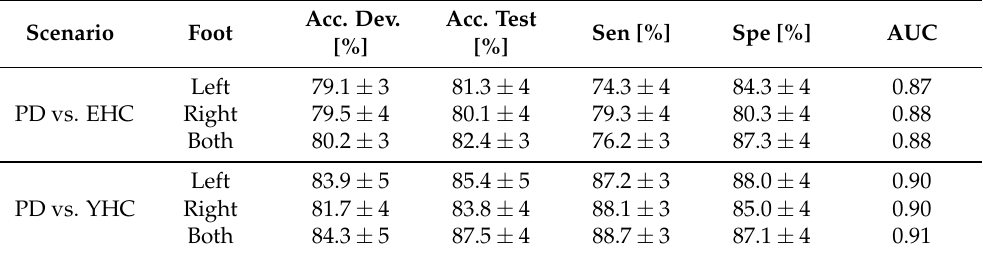
Table 2. Results using CNN and 2 × 10 m task.